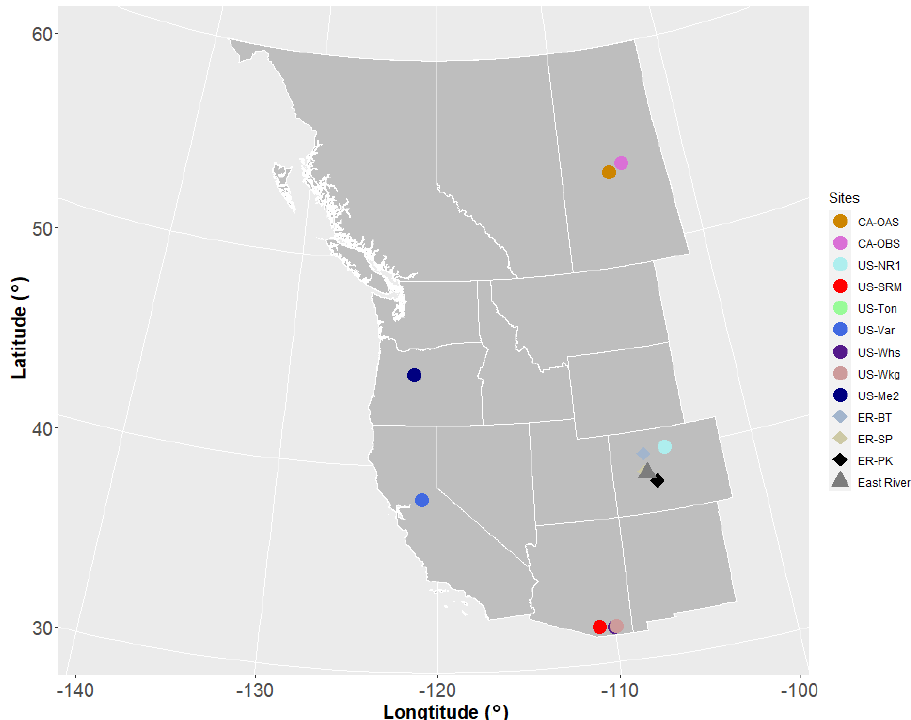
Figure 1. Location of sites considered in this study. Note that US-Ton and US-Var and US-Whs and US-Wkg are close to each other. East River Watershed is located next to ER-BT. The white lines delineate Western US states and Canadian provinces. Circles represent FLUXNET sites, diamonds represent SNOTEL sites, and the triangle represents the East River Watershed.